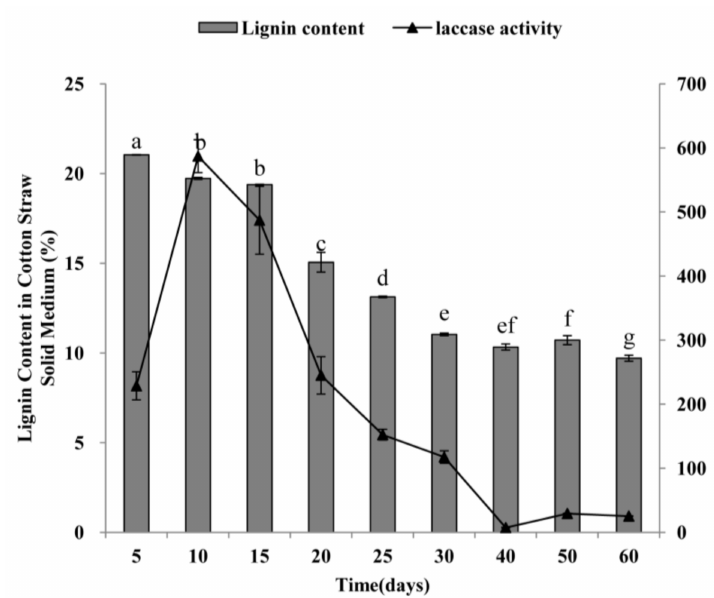
Figure 4. Evolution of the lignin content and laccase activity in solid-state fermentation (SSF) cultures of cotton-straw. The lowercase letters show a significant difference in lignin content ( p < 0.05). Values are means of three replicates ±